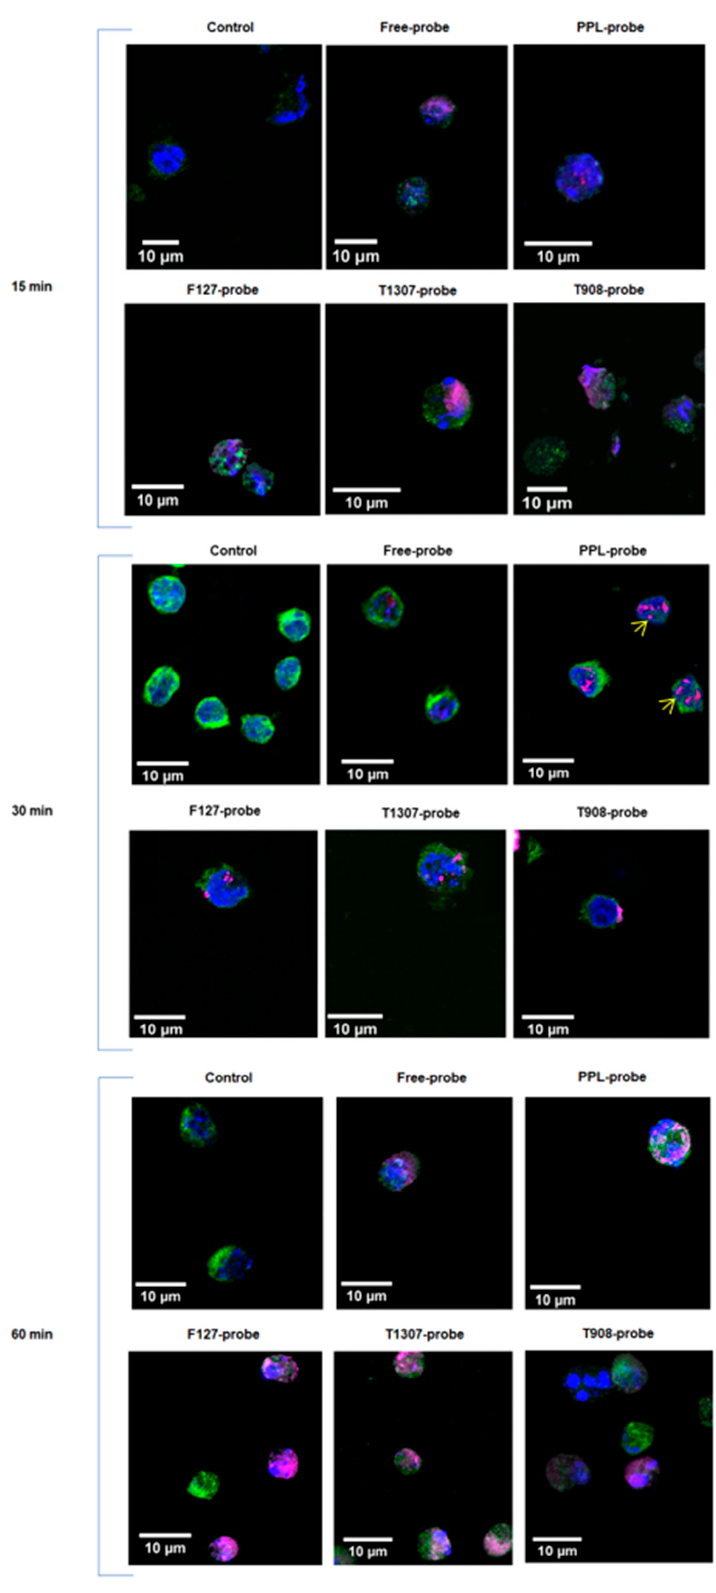
Figure 6. Confocal microscopy image of A20 cells, incubated for 15, 30, and 60 min with free-probe, PPL-probe, and PMs-probe: F127-probe, T1307-probe, and T908-probe. Yellow arrows show magenta nano-size structures corresponding with PPL-probe nanosystems. In the low panel, co-localization with the endosomal marker can be clearly observed.